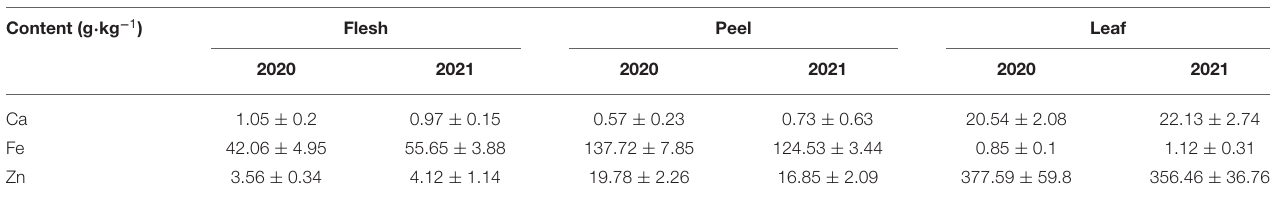
TABLE 2 | Content of mineral nutrients of the “Fuji” samples in 2